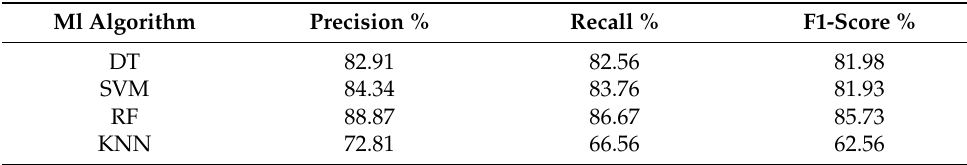
Table 6. Performance of trigram stacked autoencoder.